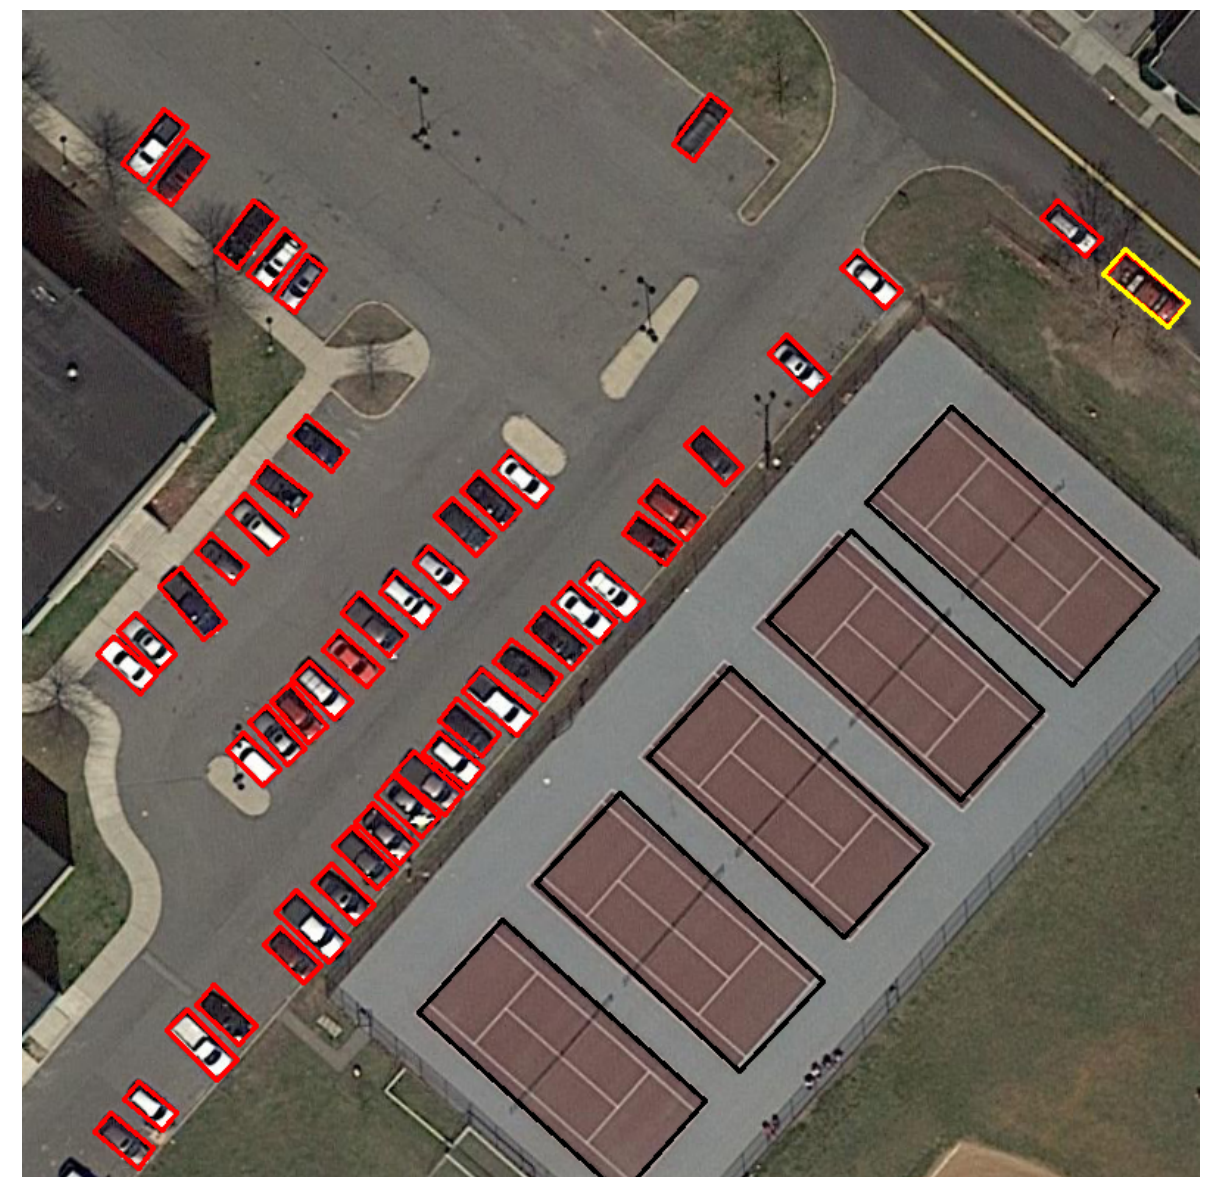
Figure 8. Qualitative result of RetinaNet predicting oriented bounding boxes. The resulting predictions are almost perfect. Longish objects which are not axis-aligned have a much tighter bounding box when predicting OBBs compared to HBBs. This also reduces the risk of the NMS dropping correct bounding boxes because of a high